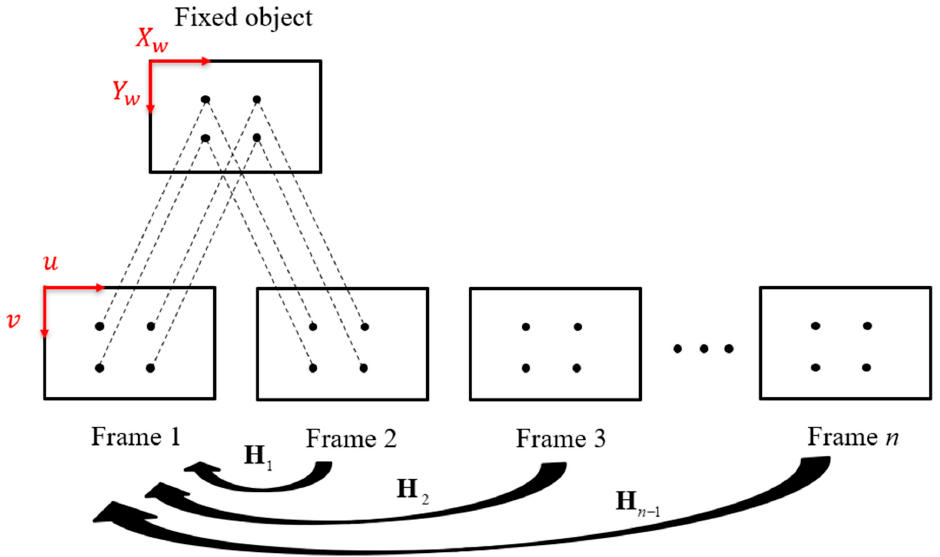
Figure 3. Homography transformation between frames.